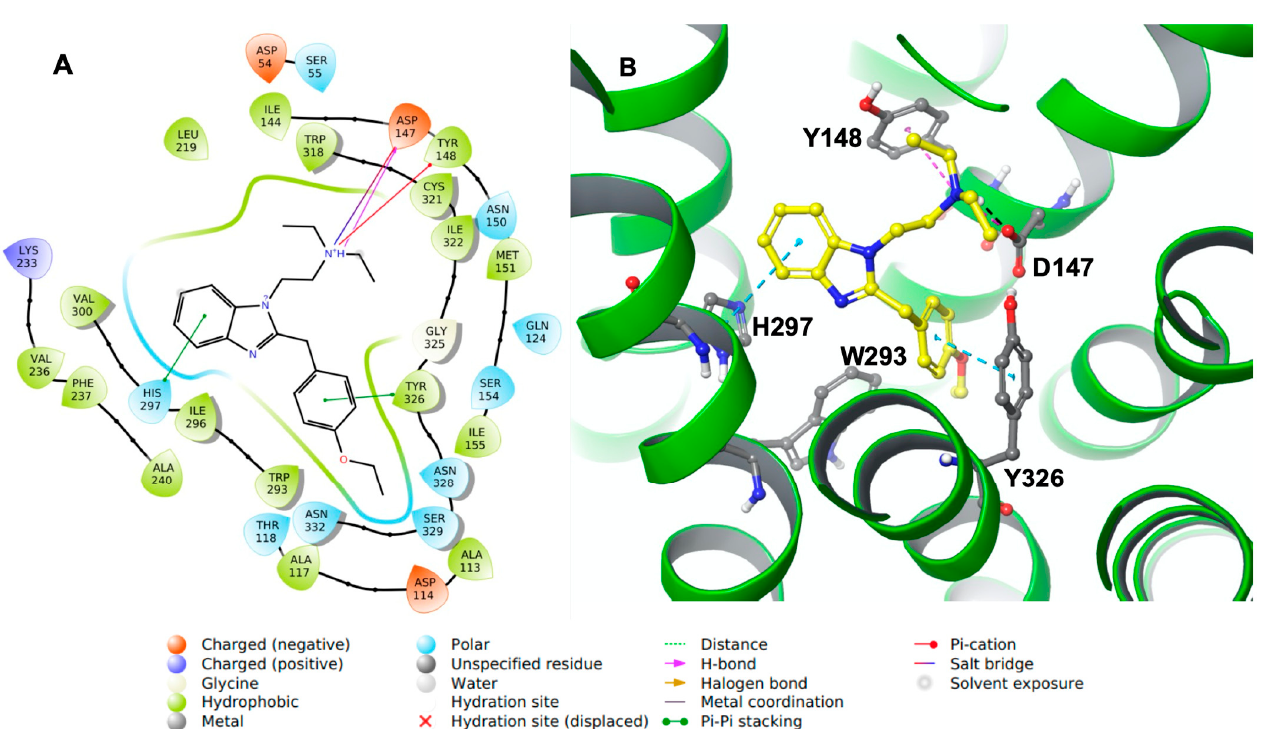
Figure 3. ( A ) The two-dimensional (2D) and ( B ) three-dimensional (3D) interaction diagram of etazene with MOR. The key residues are shown in the ball and stick model (carbon in gray), and transmembrane regions are shown as ribbons (green-colored). Etazene is shown in a ball and stick model (carbon in yellow). The distance between H297 and benzimidazole moiety (edge to face; π – π stacking): 4.7 Å and between Y326 and ethoxy phenyl (face to face; π – π stacking): 3.75 Å. The H-bond and salt bridge distances are 1.95 Å and 2.90 Å, respectively.